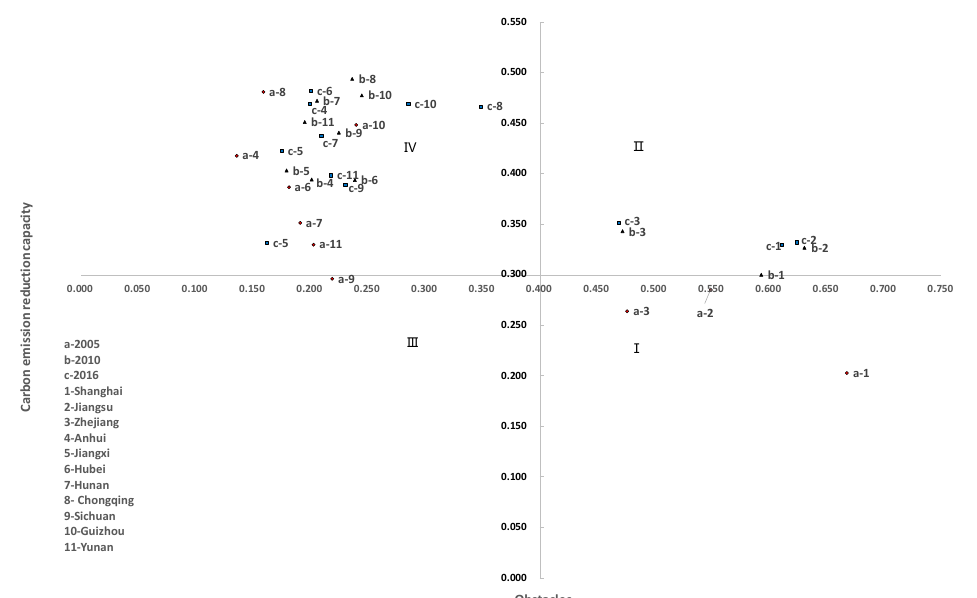
Figure 7. Four quadrants of carbon emission reduction potential in the YREB.